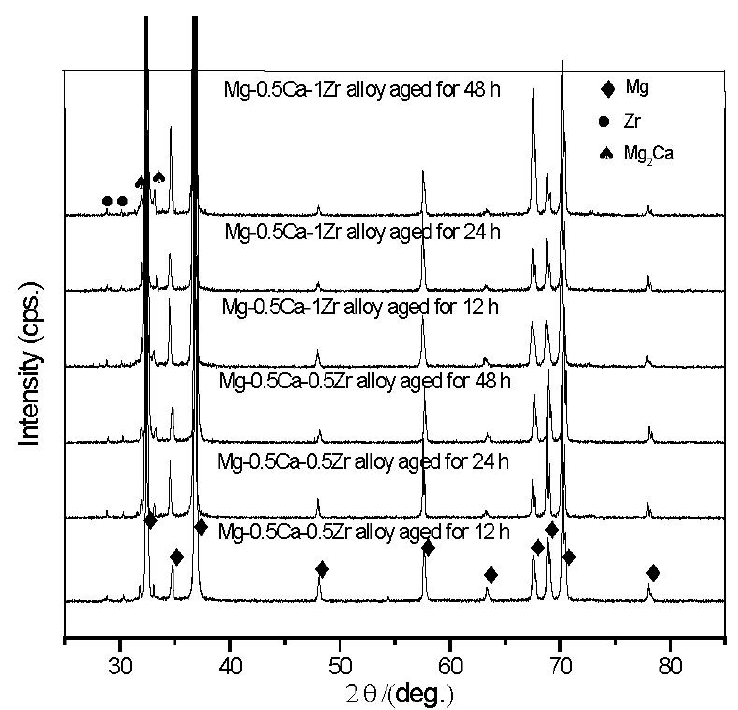
Figure 7. XRD patterns of aged Mg alloys.